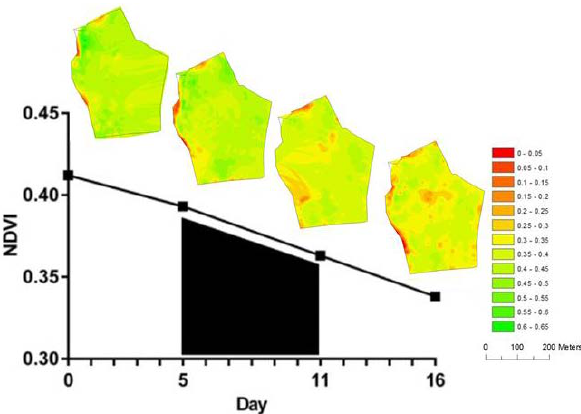
Figure 3. Normalised Difference Vegetation Index (NDVI) maps were generated every 5–6 days over the duration of the study, based on the average NDVI value of the paddock on that day. The GNSS collar period is shaded and illustrates the period of time when cattle were fitted with GNSS collars to investigate paddock utilisation.